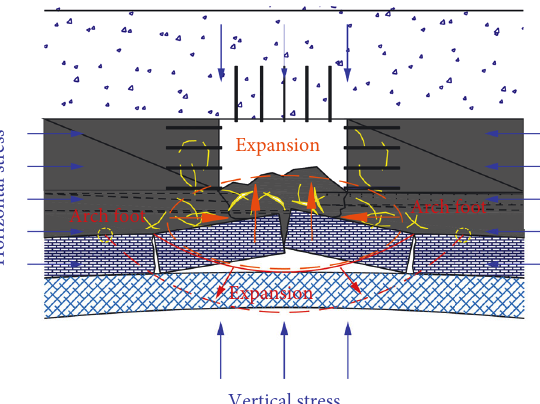
Figure 17: Evolution mechanism of the reverse arch